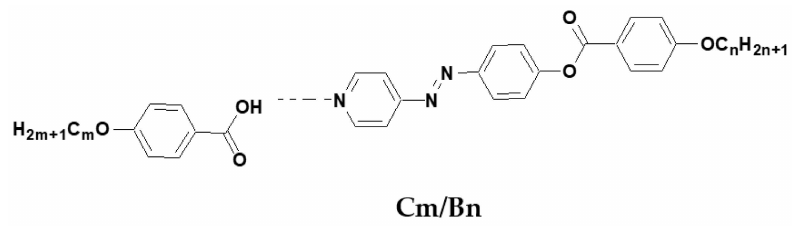
Figure 6. SMHBLC complexes of 1:1 Cm / Bn .